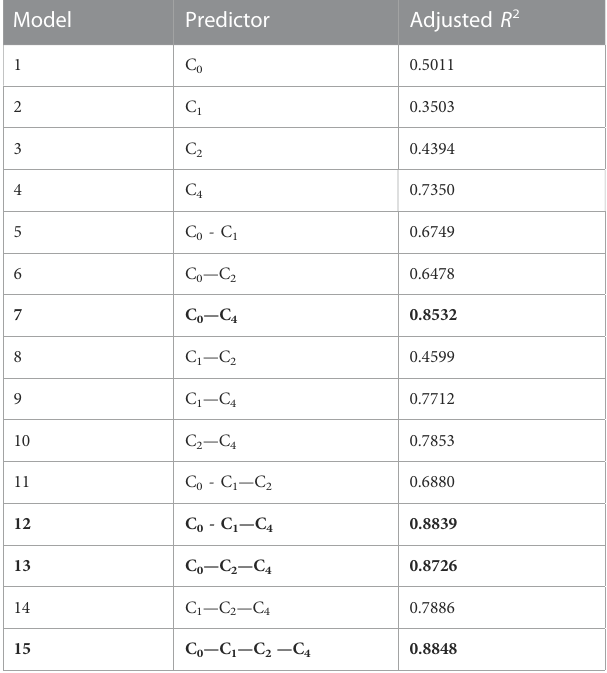
TABLE 2 Multiple regression analysis of all combinations with C 0 , C 1 , C 2 and C 4 with the adjusted r 2 for each model. This procedure generated 15 different regression models from which we selected those with an adjusted r 2 value higher than 0.799 highlighted in bold (see Patients and Methods for more